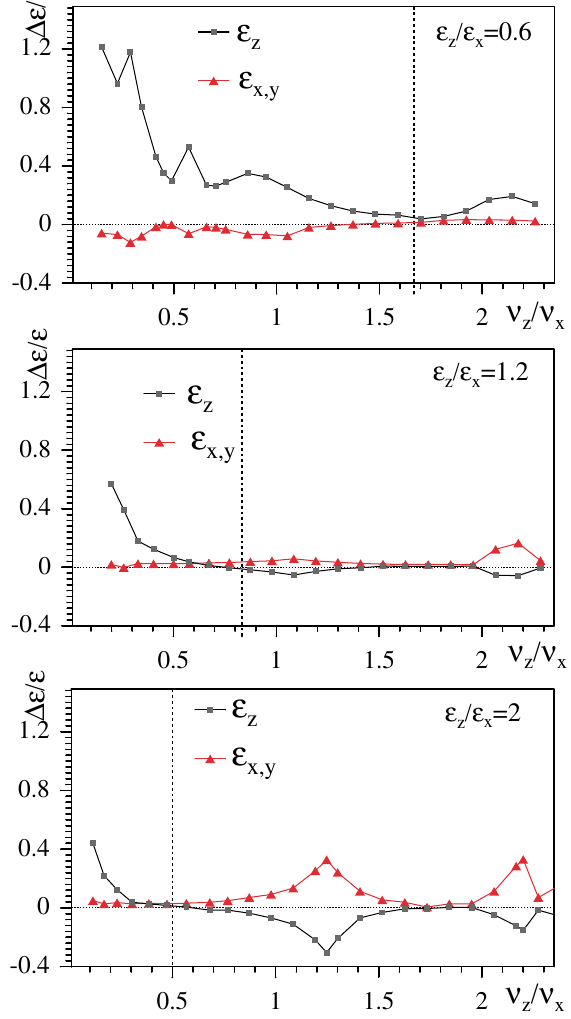
FIG. 15. (Color) 3D IMPACT code simulation results for (cid:3) 0 : 5 , and (cid:19) (cid:3) 0 : 6 , 1.2, and 2 as functions of the =(cid:10) =(cid:19) (cid:10) x z x 0 x tune ratios (dashed lines equipartitioned).